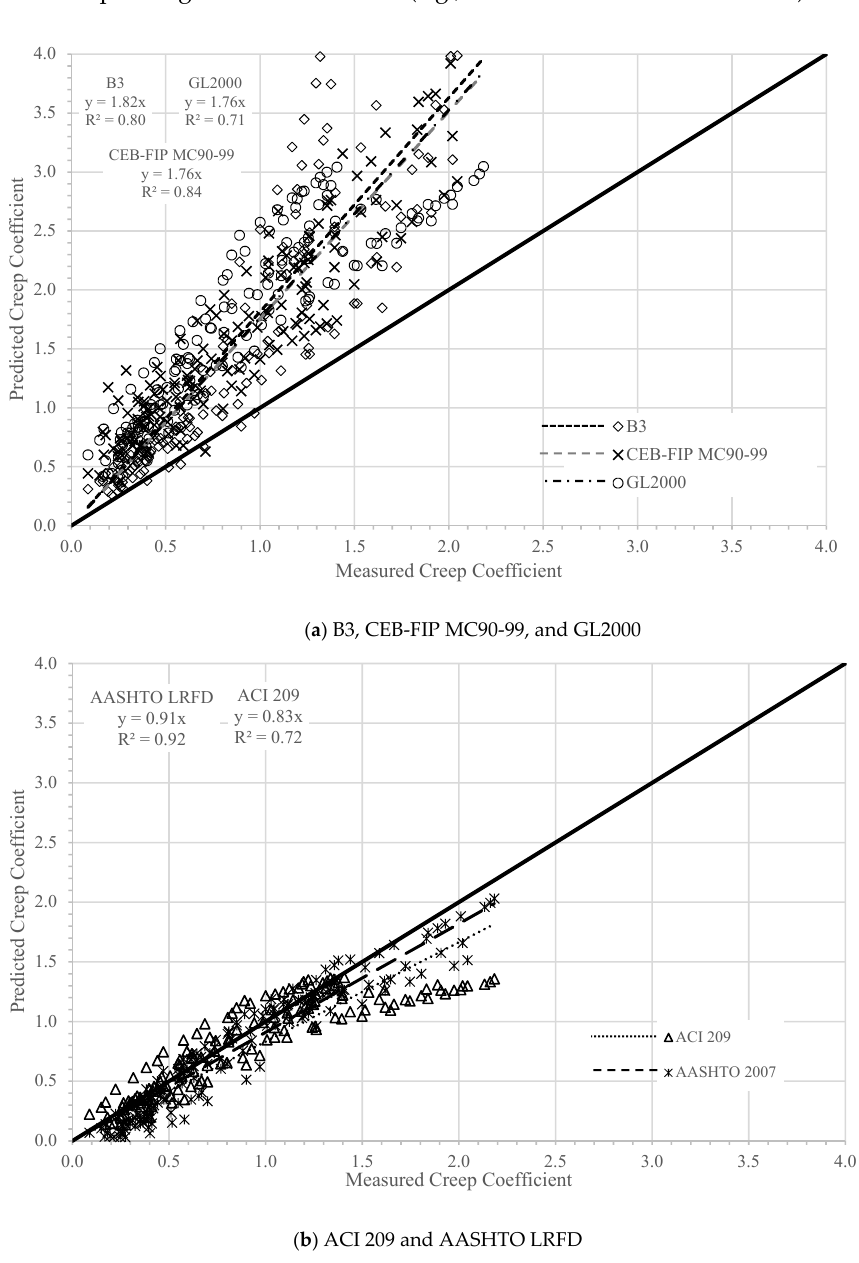
cation factor varies depending on the model used (e.g., 1.2 for AASHTO LRFD model). varies depending on the model used (e.g., 1.2 for AASHTO LRFD model).